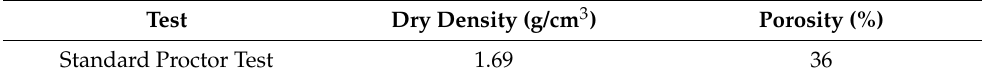
Table 3. Soil dry density and porosity.